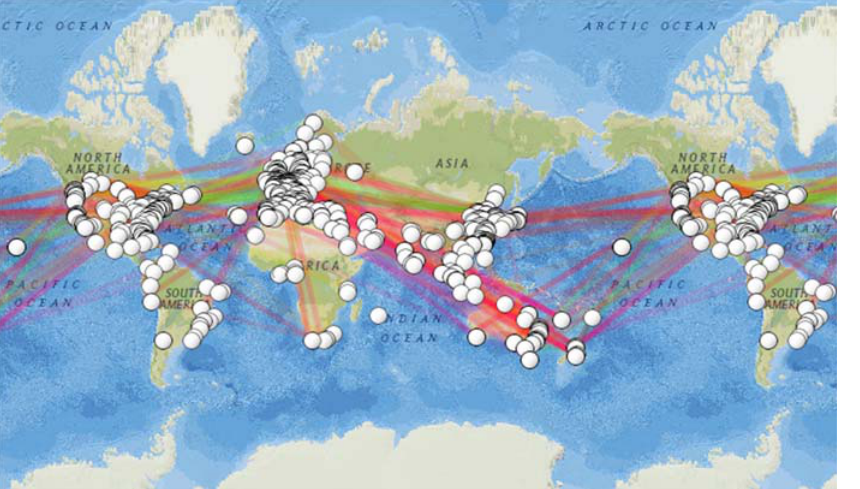
Figure 12. Geographical distribution cooperation network diagram of marine econometrics